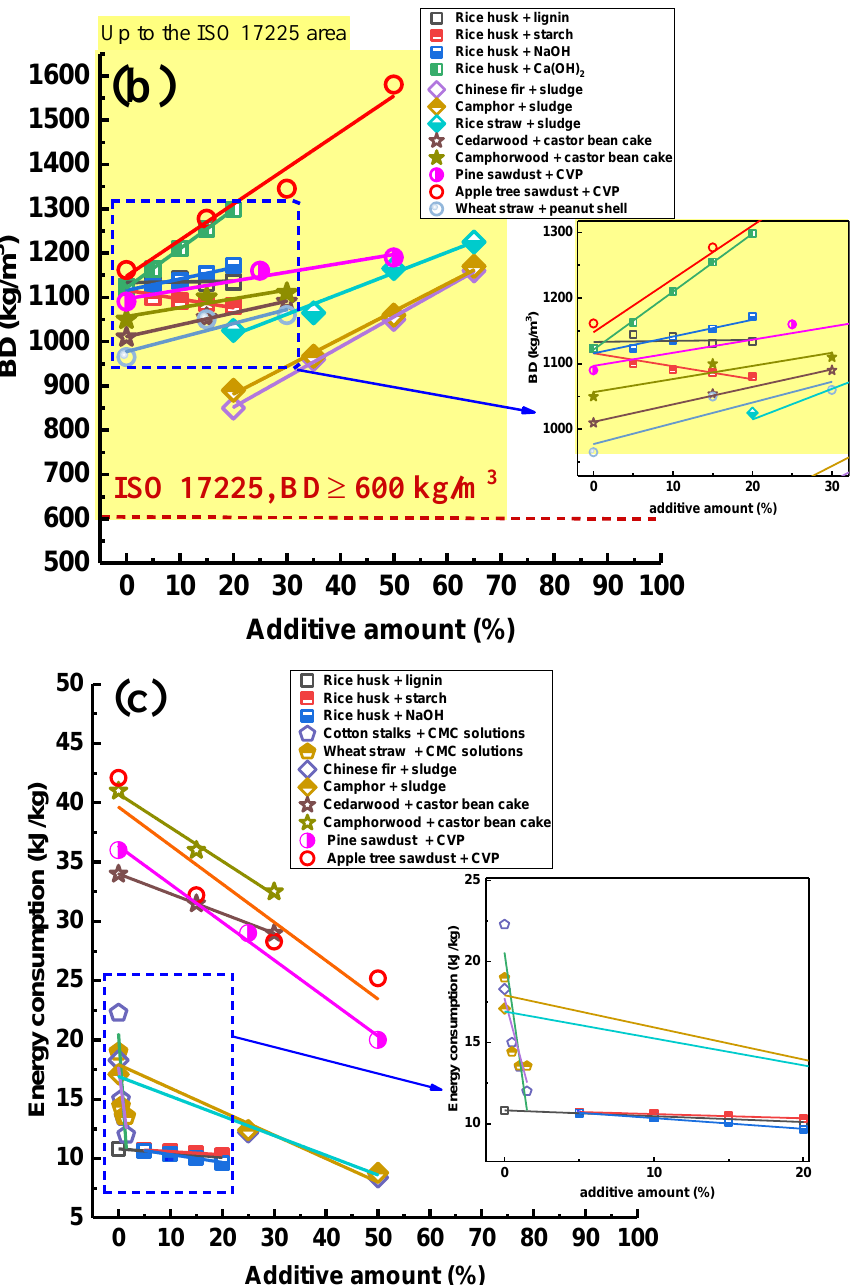
E ff ect of blending di ff erent binder amounts on physical properties of di ff erent Figure 5. Effect of blending different binder amounts on physical properties of different biomass biomass pellet fuels: ( a ) The DU [5,48–50], ( b ) the BD [5,42,46,47,51–53], and ( c ) the energy pellet fuels: ( a ) The DU [5,48–50] , ( b ) the BD [5,42,46,47,51–53] , and ( c ) the energy consumption consumption [5,46,47,49,51,52] of a [5,46,47,49,51,52] of a bio-pellet.